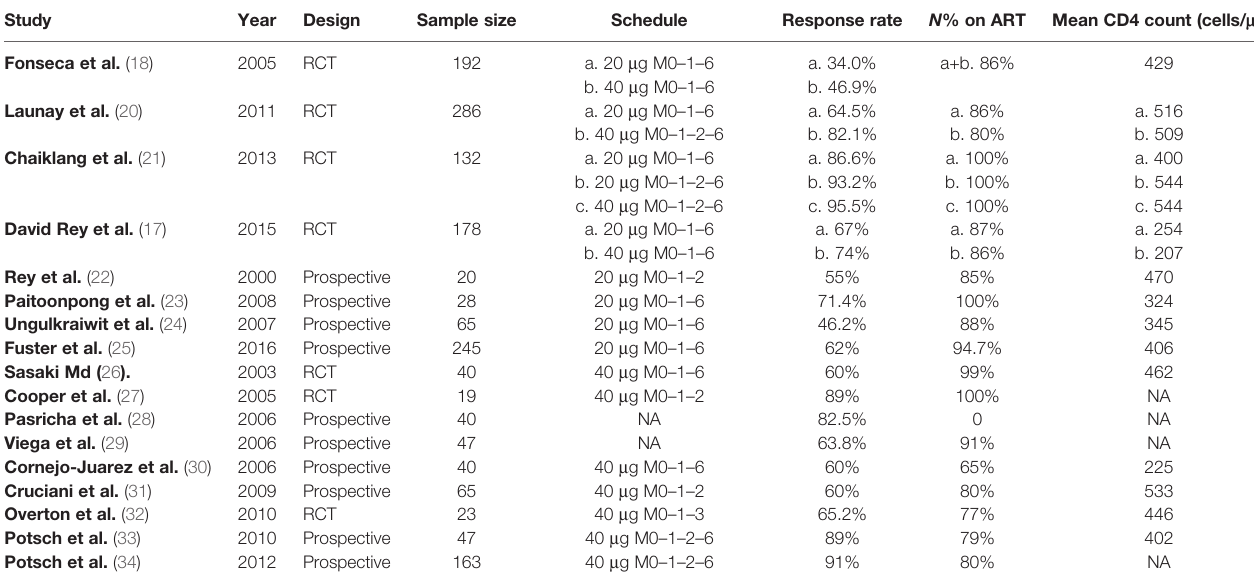
TABLE 1 | Characteristics of the included